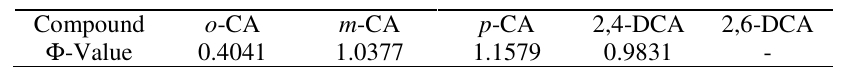
Table 4. Quantum efficiencies of